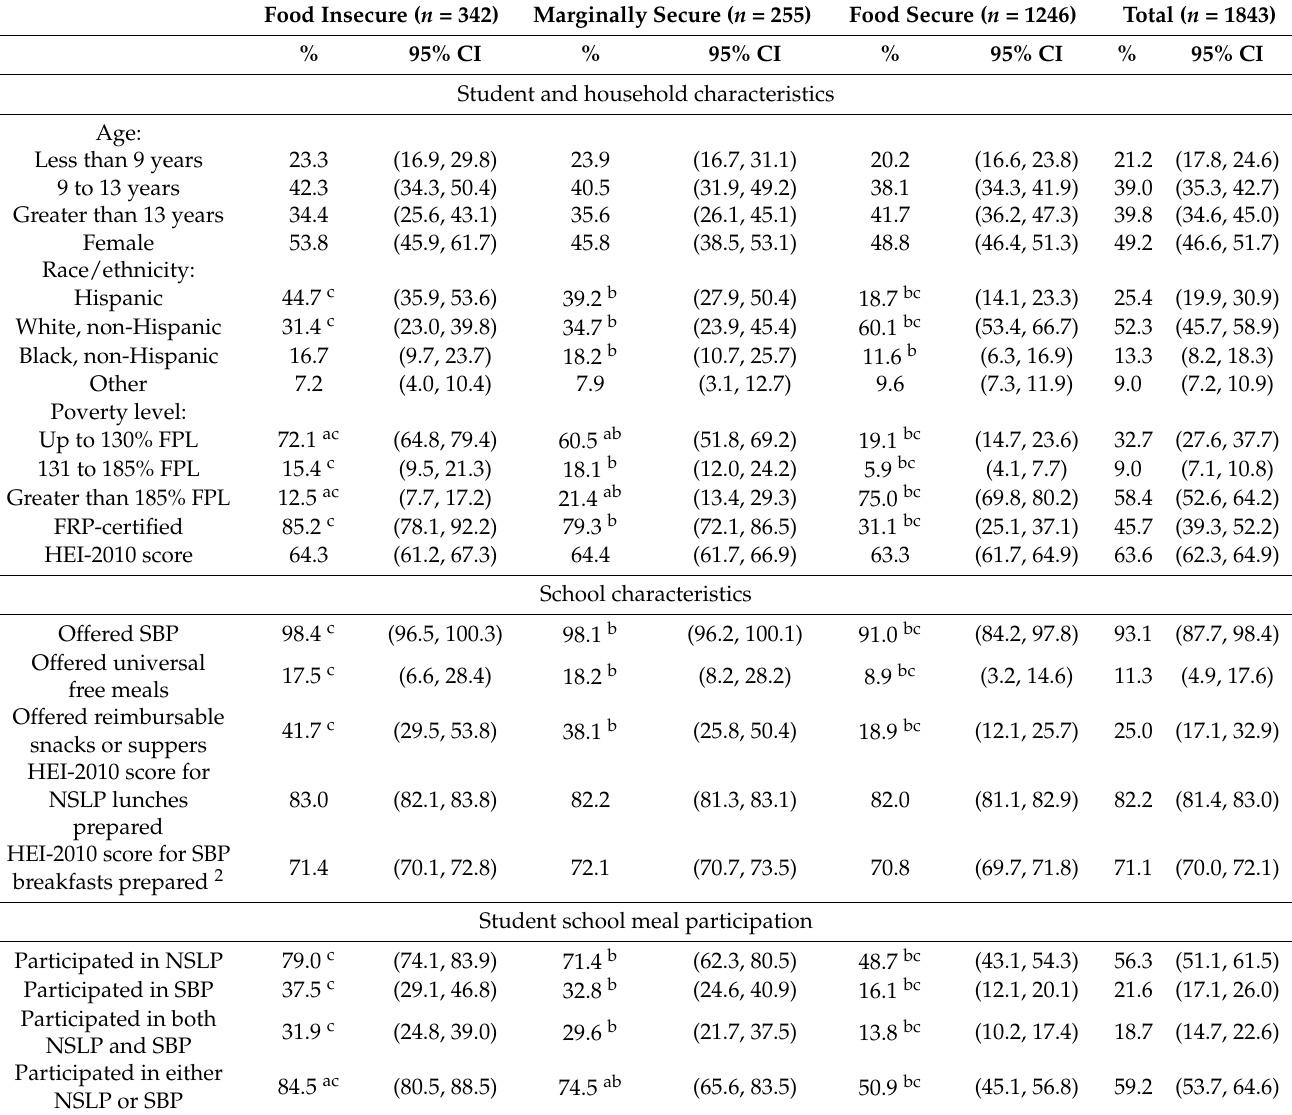
Table 2. Student, household, and school characteristics by food security status 1